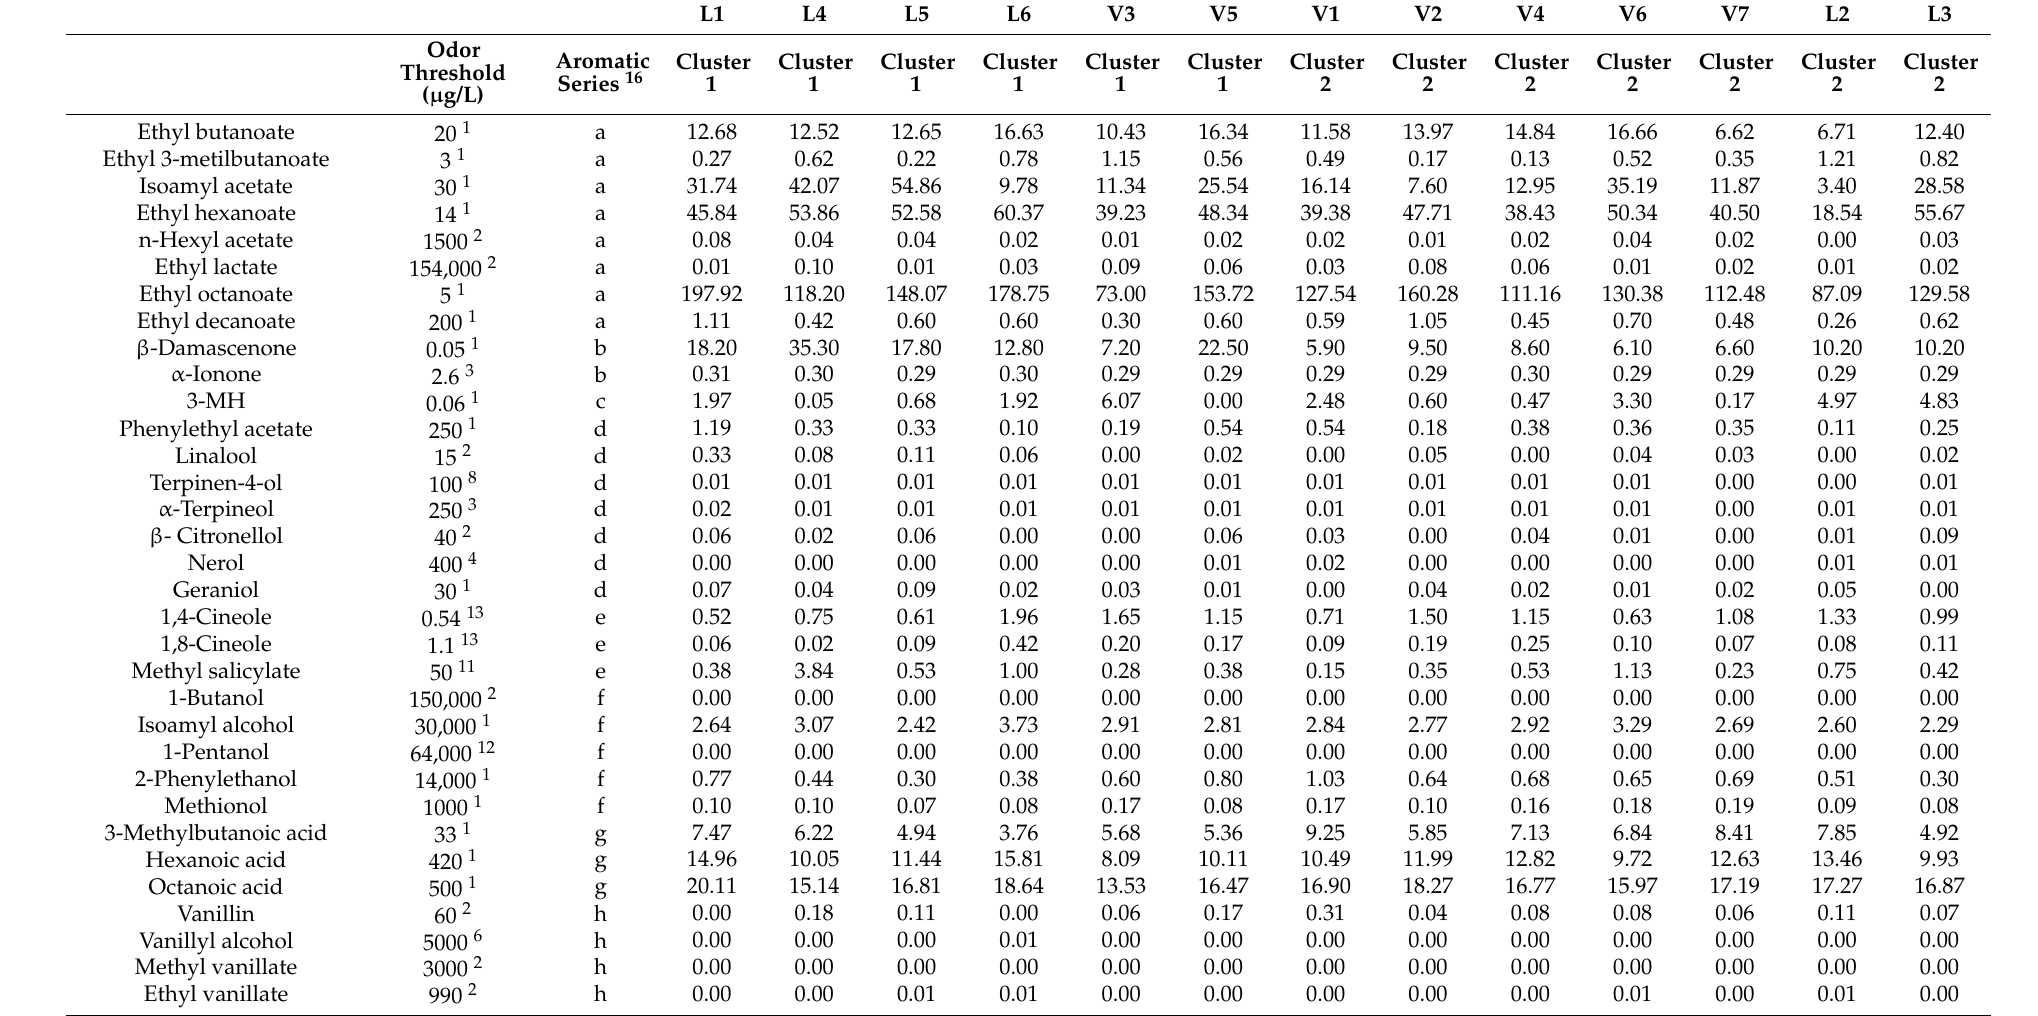
Table 4. Odour threshold ( µ g/L), aromatic series, and odour activity values of some volatile compounds of wine